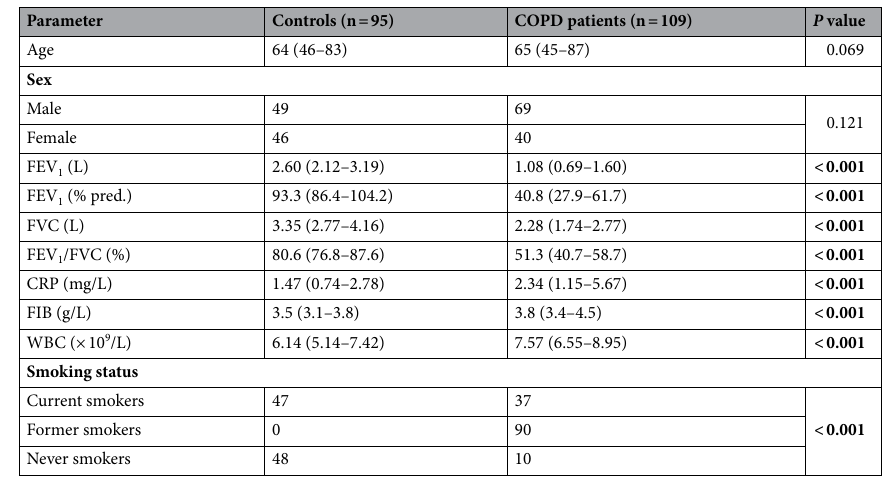
Table 1. Basic characteristics, spirometry and common inflammatory markers of all participants included in the study. Age is presented as a median with minimum and maximum, and sex is presented as an absolute number. Other parameters were shown as a median with IQR. Data was analysed by Chi-squared or Mann– Whitney test, and results were considered statistically significant when P < 0.05. Significant values are in